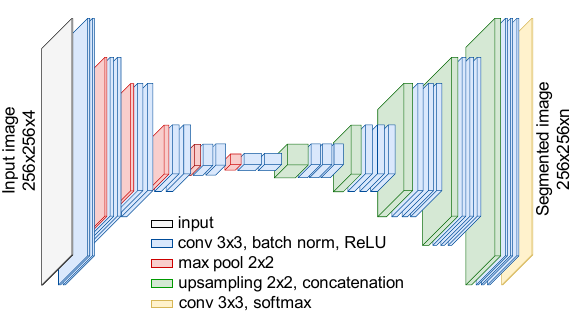
Figure 1. Architecture of the U-net model applied (best viewed in color). The segmented image has n channels, with n number of